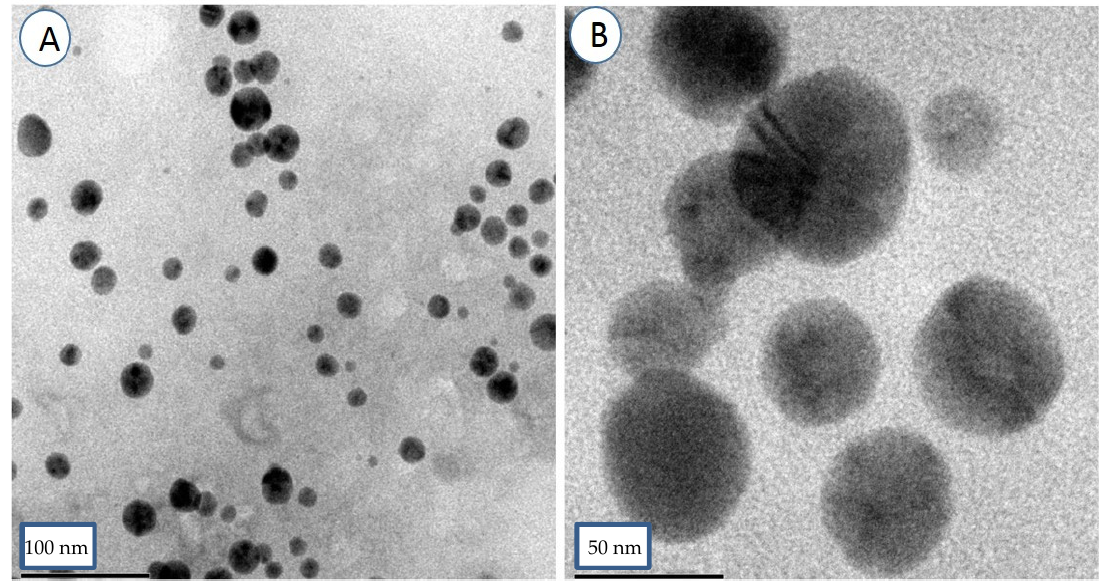
Figure 3. ( A ) and ( B ) transmission electron microscope (TEM) images of AgNPs manufactured from Asian spider flower (Asf)-leaves, showing different particle size.